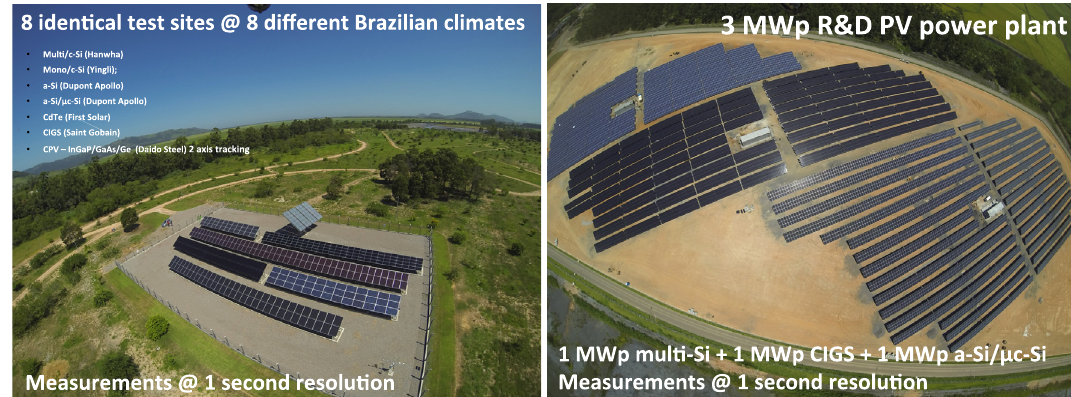
Fig. 2. One of the eight identical Evaluation Sites (ES), with 70 kWp of PV using seven PV technologies (left), and the 3MWp R&D PV power plant using three PV technologies